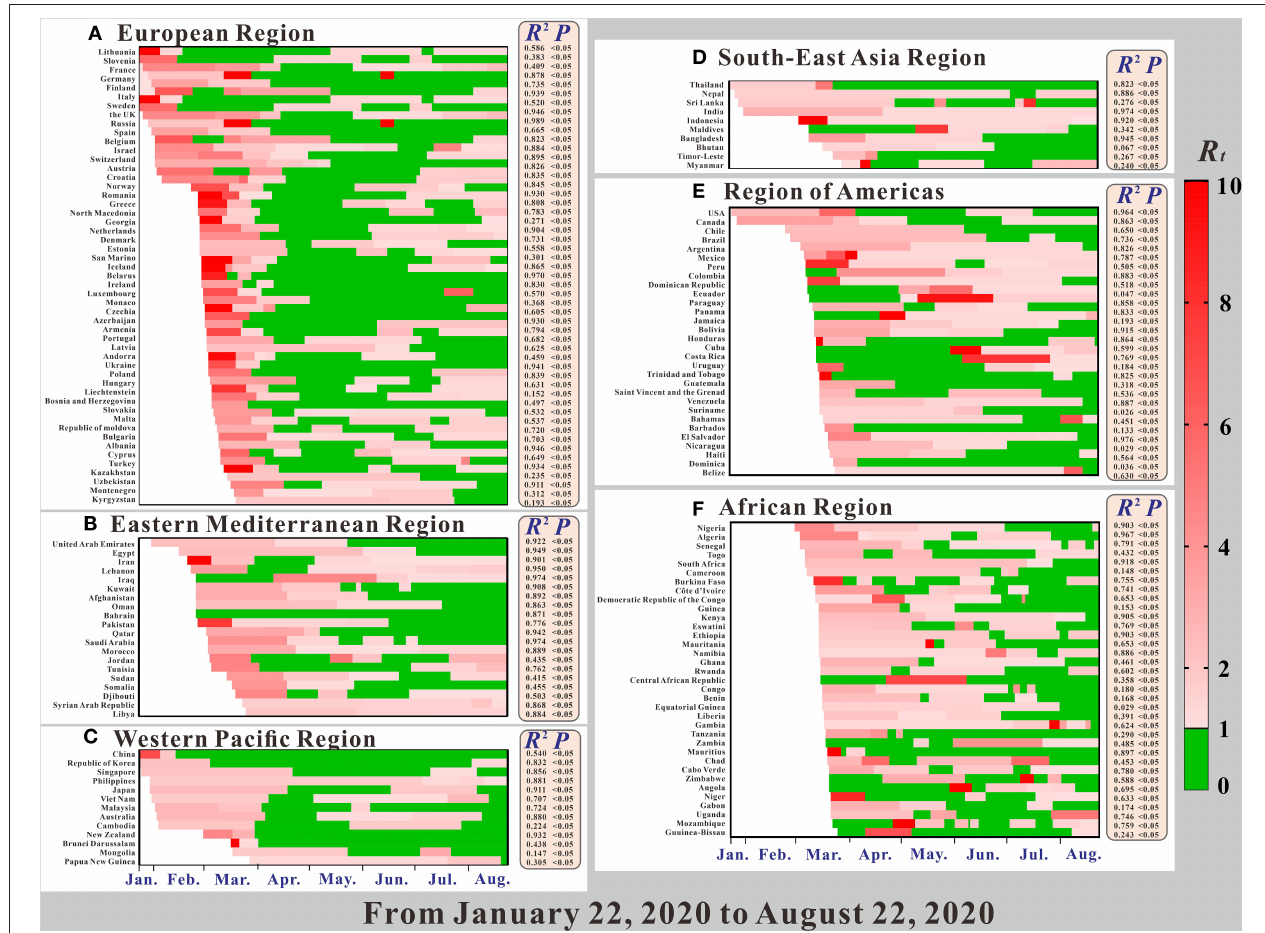
FIGURE 4 | The time-varying reproduction number ( R t ), the coefficient of determination ( R 2 ), and p of model fitting